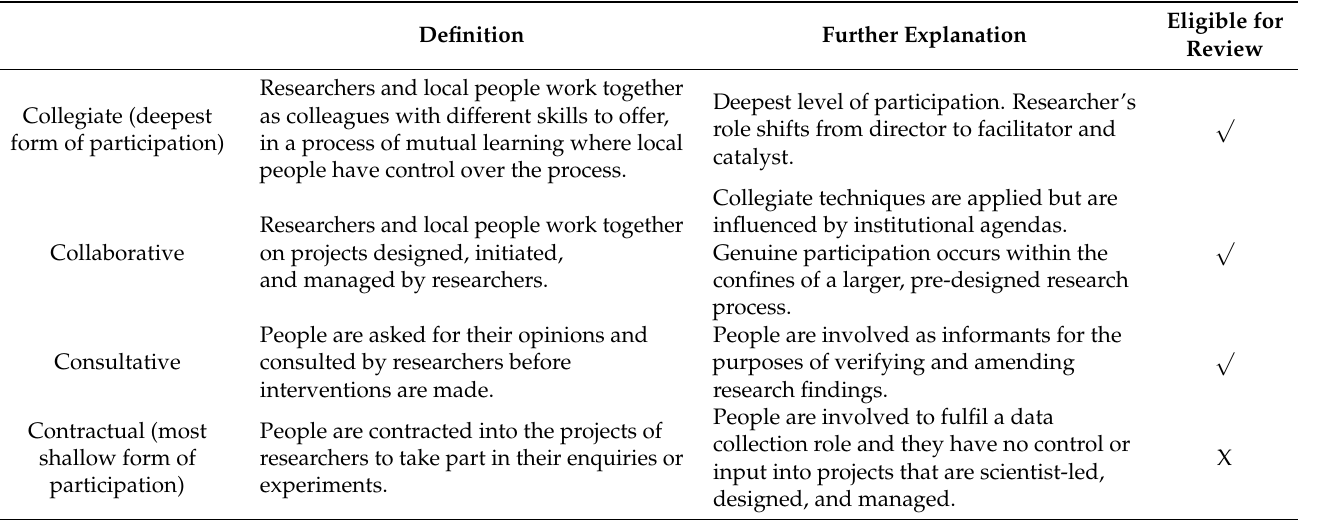
Table 1. Definitions, explanations, and eligibility of different levels of participation as described by Cornwall and Jewkes [19] and Biggs